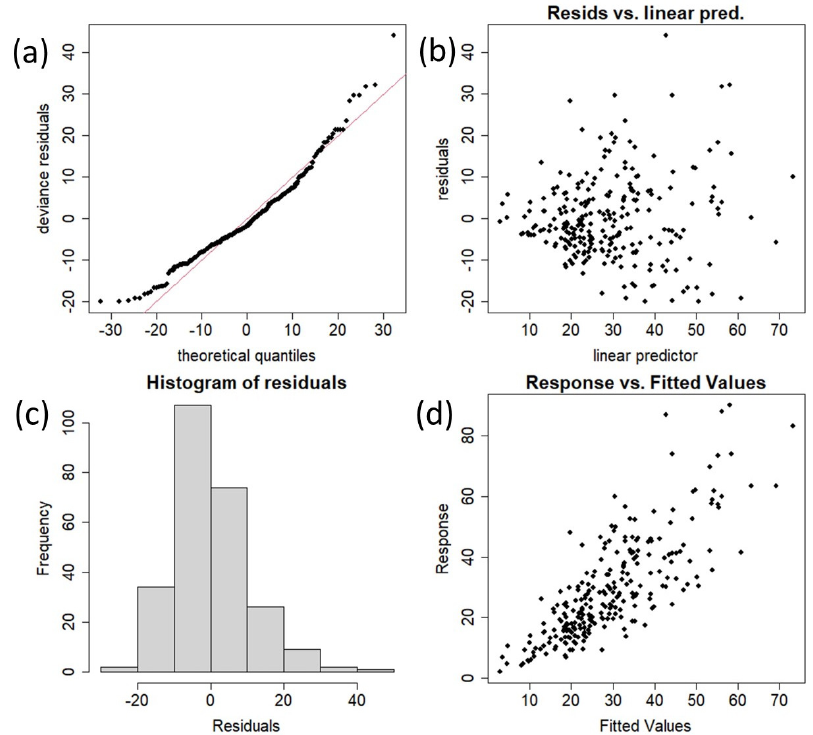
Figure 6. Diagnostic plots of generalized additive model (model six, see Table 9. ( a ) Q ‐ Q plot, ( b ) residual plot, ( c ) density plot of residuals, ( d ) fitted values plotted against response variables.